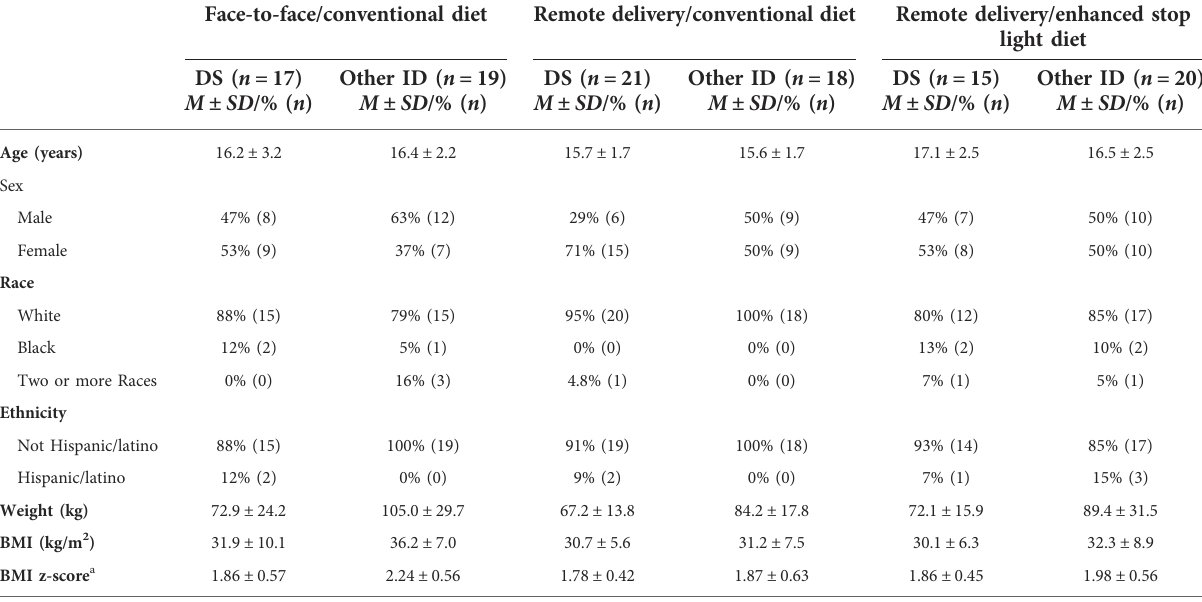
TABLE 1 Baseline characteristics of adolescents with down syndrome (DS) or other intellectual disabilities (ID) by intervention arm.